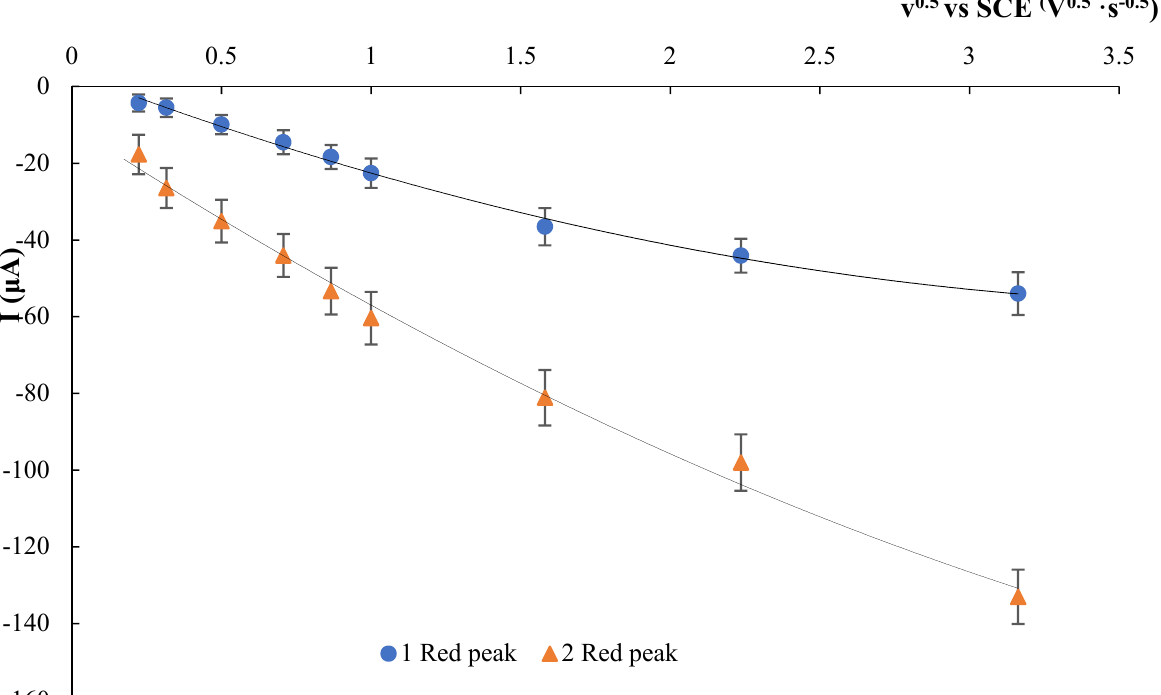
Figure 7. Change in the current of the reduction peaks for 3 mM compound 1a from v 0.5 in DMF (0.1 M Bu 4 NBF 4 ).